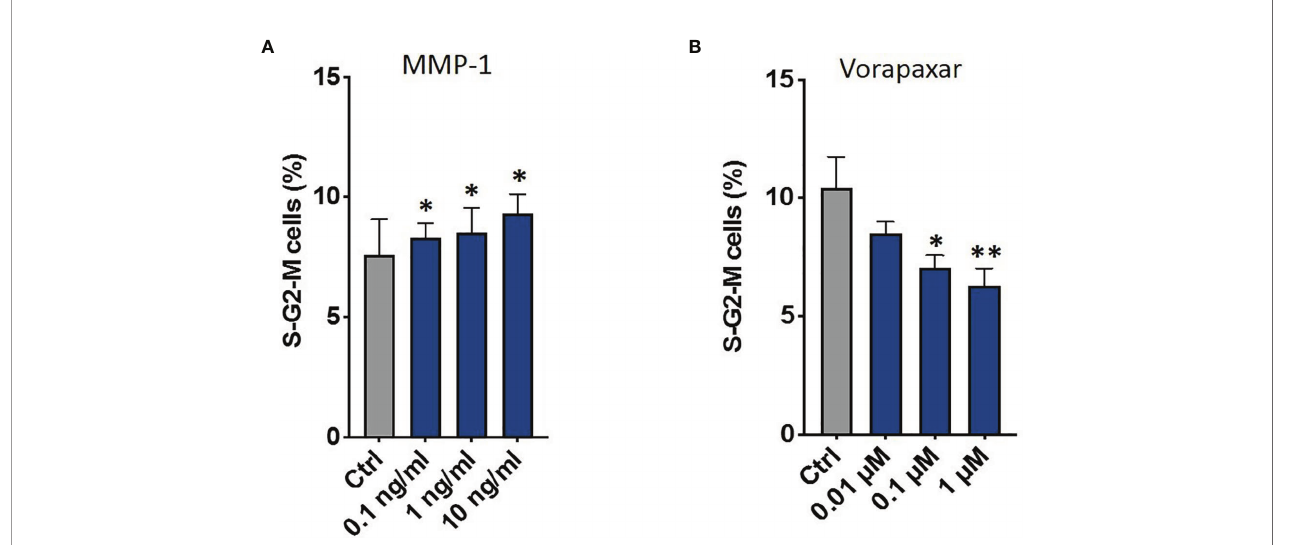
FIGURE 8 | Combination of PI and Ki-67 staining in C4-2B FR cells treated with OCM. Schematic representation of C4-2B cells percentage in S-G2-M phases treated with C4-2B CM supplemented with MMP-1 (A) and with OCM in the presence of different dosages of vorapaxar (B) . *p < 0.05; **p < 0.001.